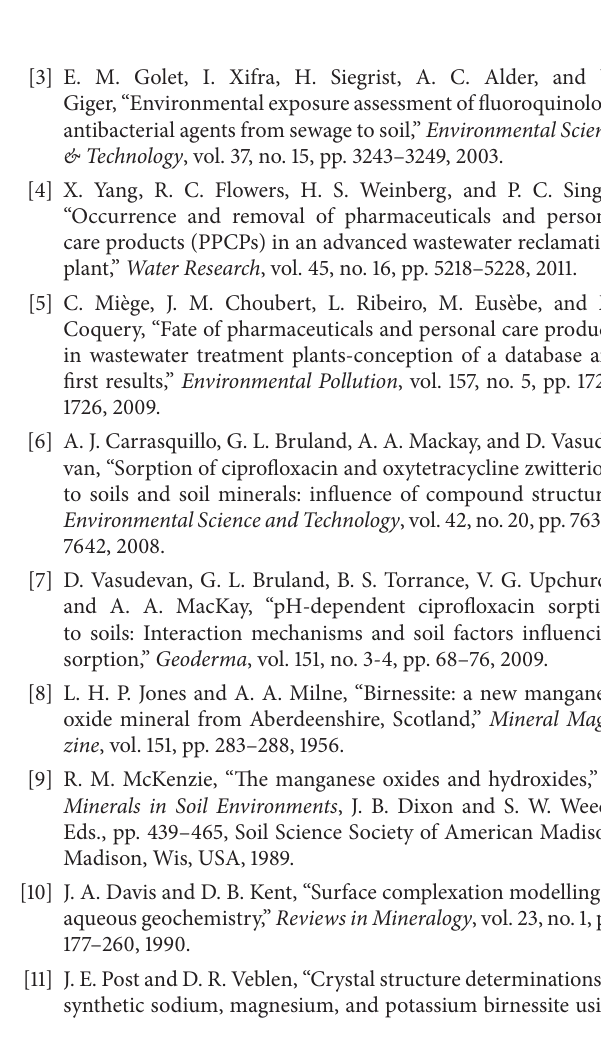
Figure 8: Energy (KJ/mol) of birnessite and CIP in the system of different samples (a) and energy difference compared with the energy of sample I